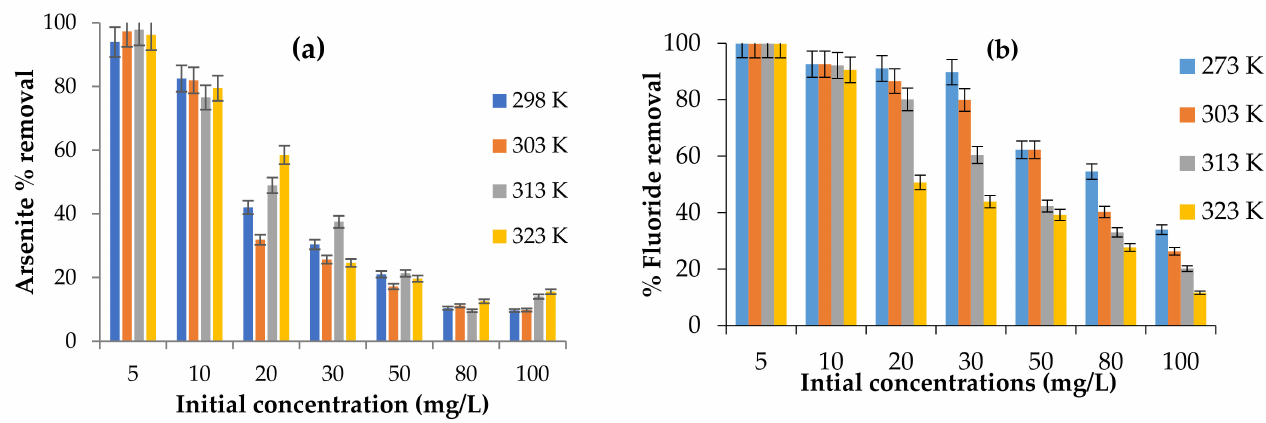
Figure 9. Effect of initial concentrations on ( a ) As 3+ and ( b ) F − sorption at different working temperatures. Initial F − and As 3+ concentration: 5 and 10 mg/L; adsorbent dose: 0.25 g and 0.2 g; solution volume: 50 mL; contact time: 24 h; shaking speed: 250 rpm; and temperature ranges: 298–323 K.